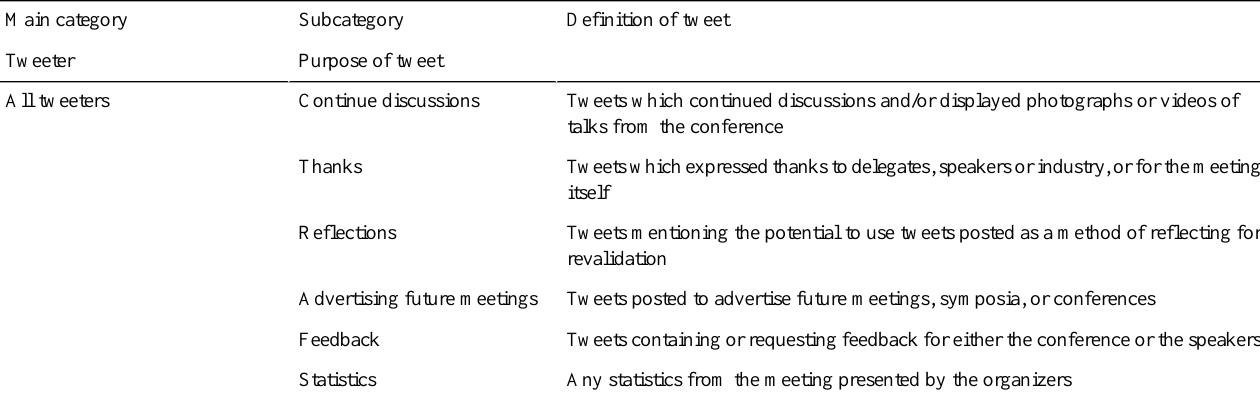
Table 3. Tweets sent after the January 2012 Association of Anaesthetists of Great Britain and Ireland (AAGBI)